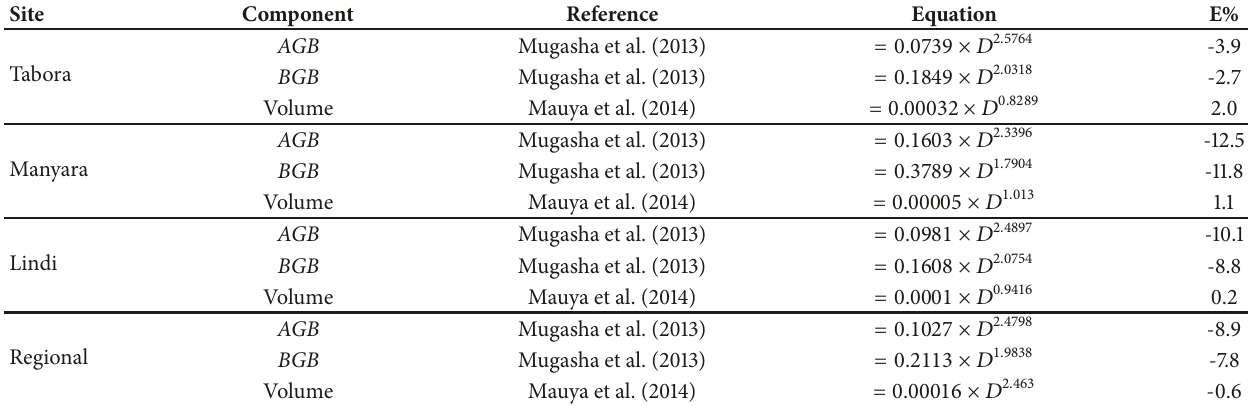
Table 7: Evaluation of some previous developed models for estimation of tree